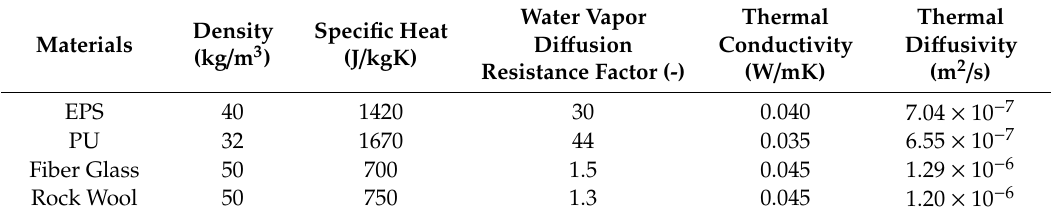
Table 3. Hygrothermal property of roof insulation layers